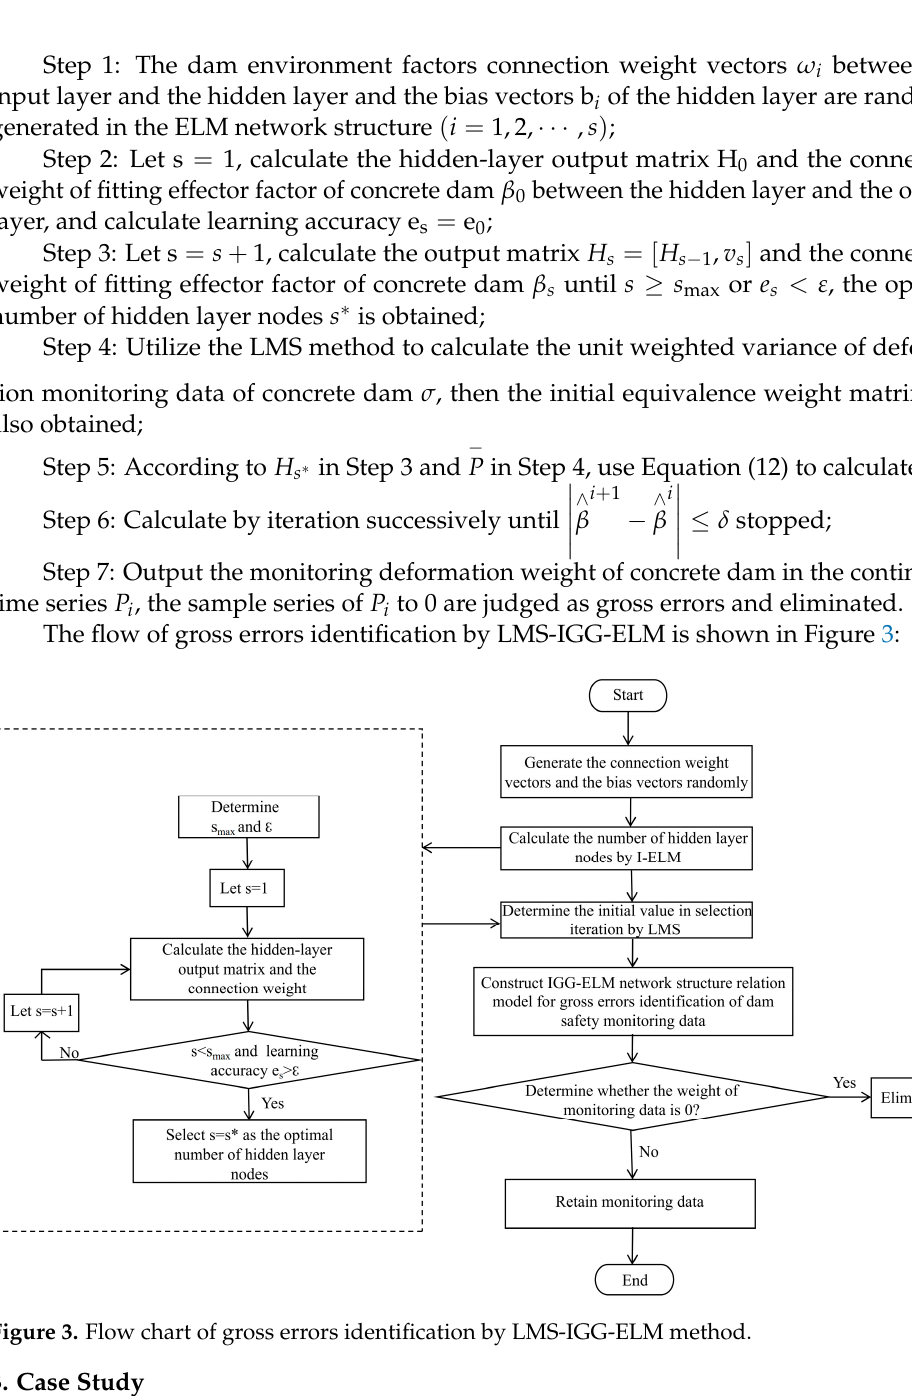
Figure 4. Actual and three-dimensional modeling drawing of the double-curved arch dam. 3.2. Selection of Model Influence Factors and Division of Data Sets In the process of concrete dam operation, the dam is subject to a combination of water pressure, uplift pressure, sediment pressure and temperature load. The water pressure component ( H δ ), temperature component ( T δ ) and aging component ( θ δ ) are selected as independent variables, and the displacement vector of the dam deformation ( δ ) is se- lected as a dependent variable. ELM is utilized to establish the nonlinear mapping be- tween independent variables and dependent variables, which can better construct the pre- diction model of dam deformation displacement. Its expression is as follows: